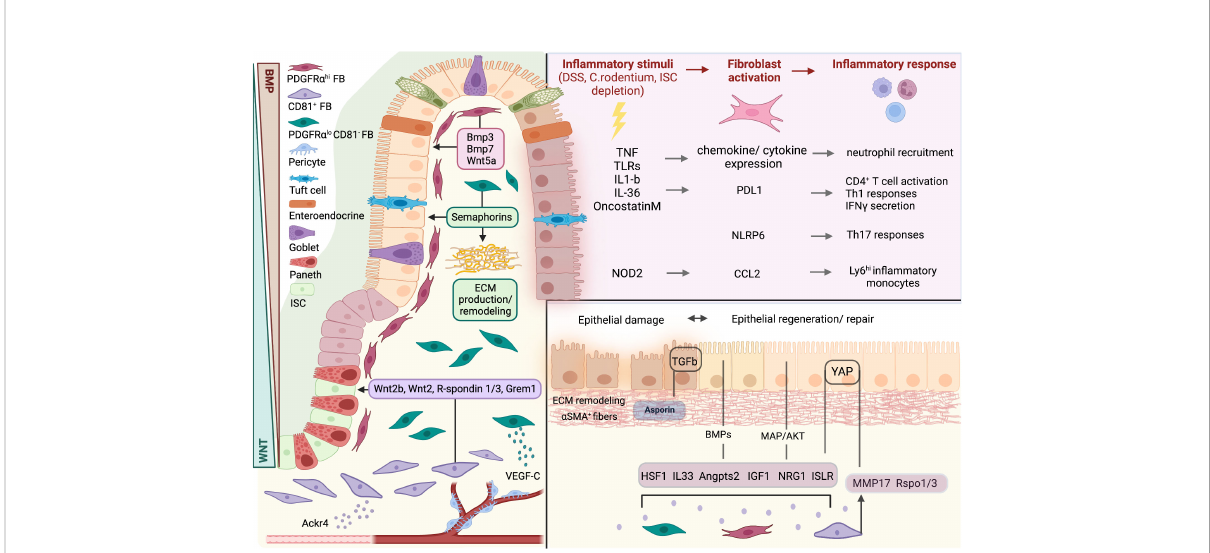
FIGURE 1 Fibroblasts in intestinal homeostasis, damage, and repair. Intestinal homeostasis is regulated by 3 distinct fi broblast subsets through the production of effector molecules. WNT ligands, R-spondins and Gremlin 1 are produced by CD81 + fi broblasts and maintain intestinal stem cell (ISC) identity. PDGFR a hi fi broblasts orchestrate epithelial differentiation through the production of BMPs and WNT5A. In the lamina propria, PDGFR a lo CD81 - fi broblasts contribute to extracellular matrix (ECM) production and remodeling. Upon in fl ammatory stimuli, fi broblasts are activated and secrete a variety of pro-in fl ammatory factors to drive immune cell recruitment and function. During damage, intestinal fi broblasts provide paracrine signals to promote epithelial regeneration and ECM remodeling. FB, fi broblast; ISC, intestinal stem cell. Created with